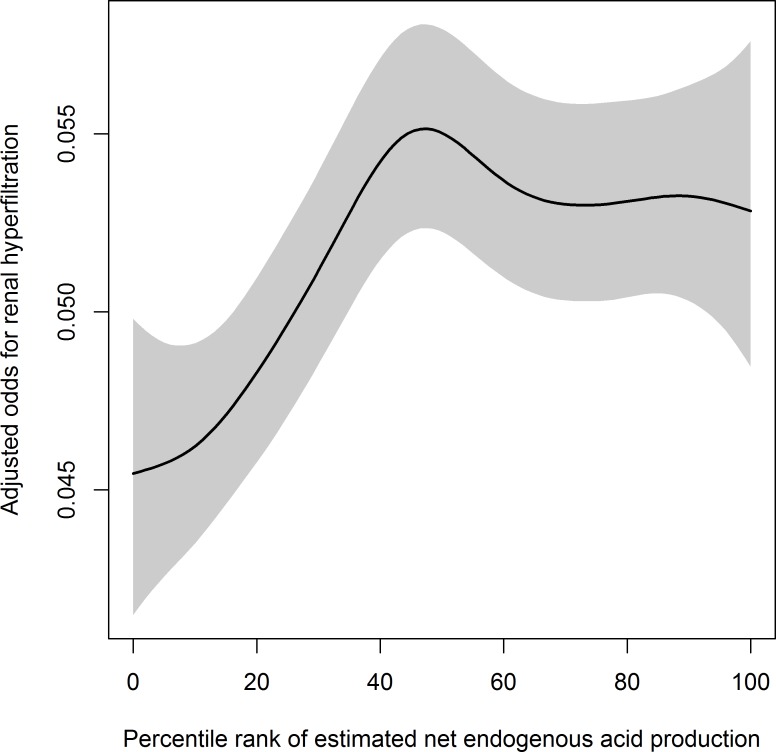
The association between renal hyperfiltration and the percentile rank of estimated net endogenous acid production (NEAP).Logistic regression analysis was adjusted for systolic blood pressure, alcohol intake, smoking status, regular exercise, fasting serum glucose, serum triglyceride, serum high density lipoprotein cholesterol, and albuminuria. Penalized splines were used for smoothing and the degree of freedom of splines was selected by a generalized cross validation method. Shaded area means 95% confidence interval. See Subjects and Methods for the definition of renal hyperfiltration and NEAP.